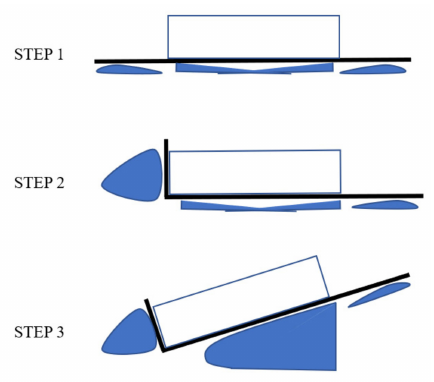
Figure 6. Three steps in the turnover process.